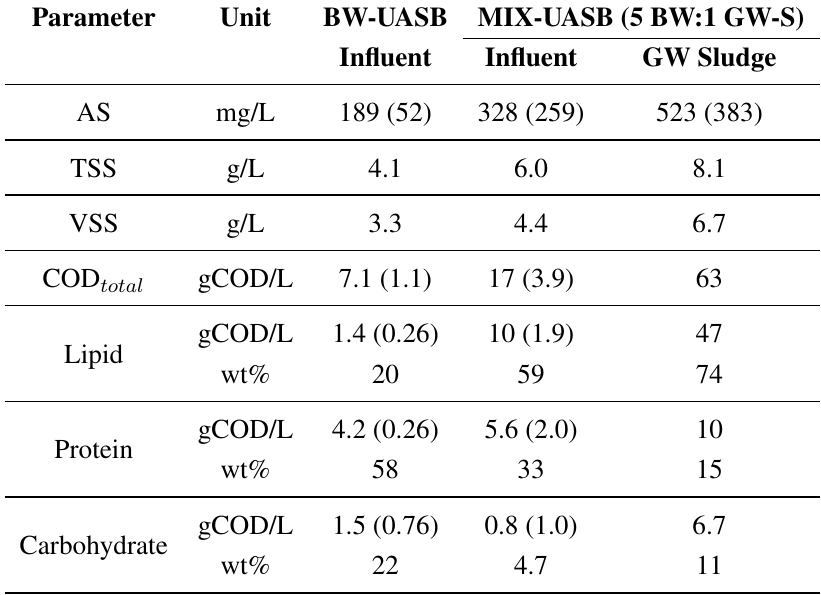
Table 1. Surfactants and organic components in the influent of the UASB reactors and the grey water sludge added to the MIX-UASB reactor. GW, grey water; AS, anionic surfactants; TSS, total suspended solids; VSS, volatile suspended